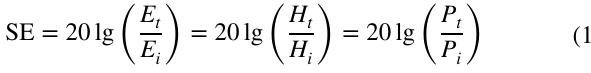
Fig. 3 Schematic diagram of EMI shielding mechanism based on transmission line